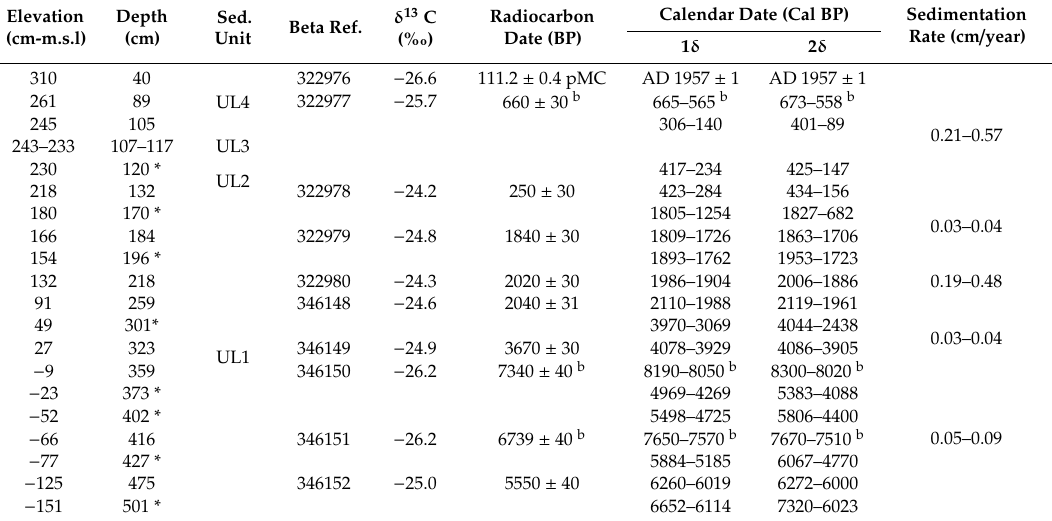
Table 1. Results of radiocarbon dates, including the calculation of the deposition rates, as well as the calibrated dates for various depths. The unit UL3 corresponds to a possibly high energy event, eventually deposited by the tsunami that followed the CE 1755 Lisbon earthquake. Adapted from Ramos-Pereira et al. (2019). Elevation